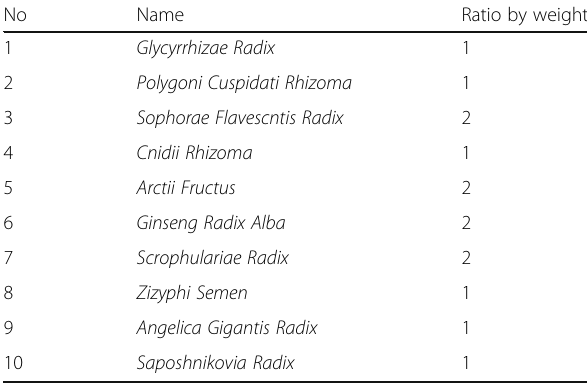
Table 1 The weight ratios of each constituent in